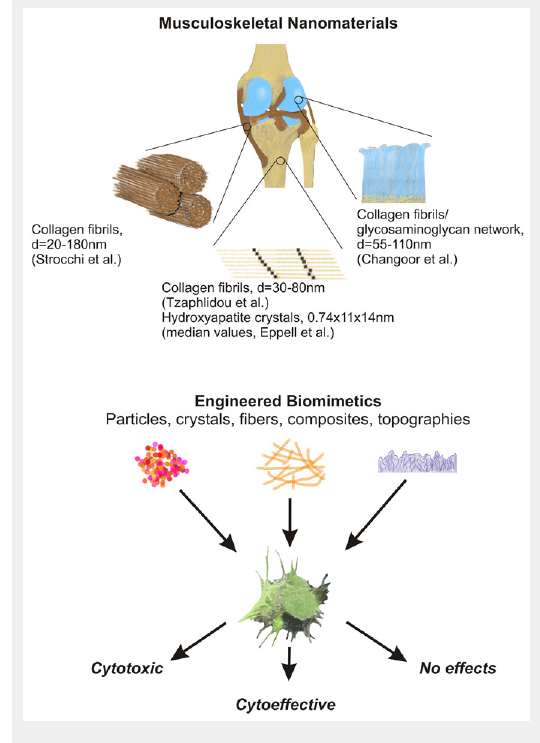
Musculoskeletal tissues – the prototypes of nanomaterials. The structural composition of ligaments/ tendons, bone and cartilage is very similar, although these tissues have quite a distinct appearance. In a simplified approach they consist of a characteristic network of collagen fibrils with diameters of approximately 100 nm embedded within a tissue specific matrix. Appropriate engineering of nanobiomaterials making use of particles, crystals, fibres, composites or surface topographies may lead to biomimetic constructs that exhibit a favourable inductive interplay with the host cells and tissues. Detailed and